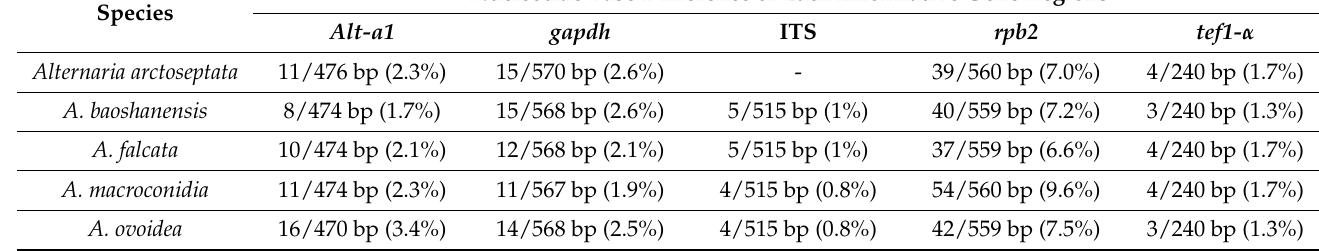
Table 2. A nucleotide base comparison of Alternaria obpyriconidia with other phylogenetically related